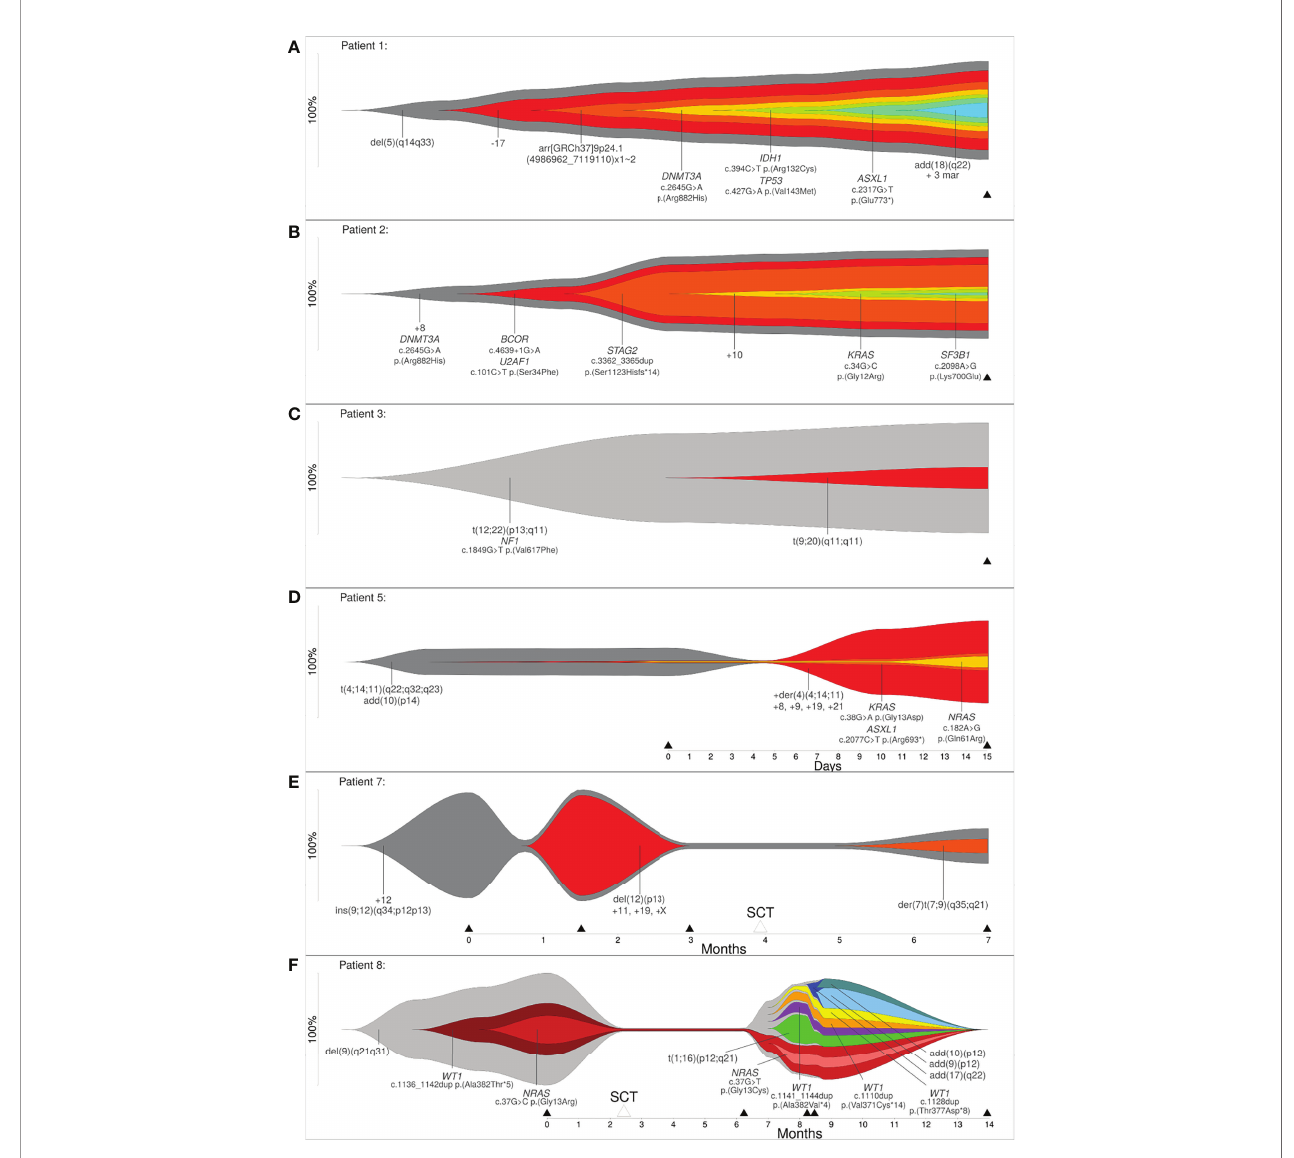
FIGURE 2 | (A – C) Reconstruction of clonal evolution of three patients analyzed at one time point. (D – F) Clonal evolution patterns of patient 5 (linear evolution), patient 7 (branched evolution) and patient 8 (neutral evolution). Y-axis represents the percentage of clone size, black triangles indicate the analyzed time point and white triangles indicate time point of stem cell